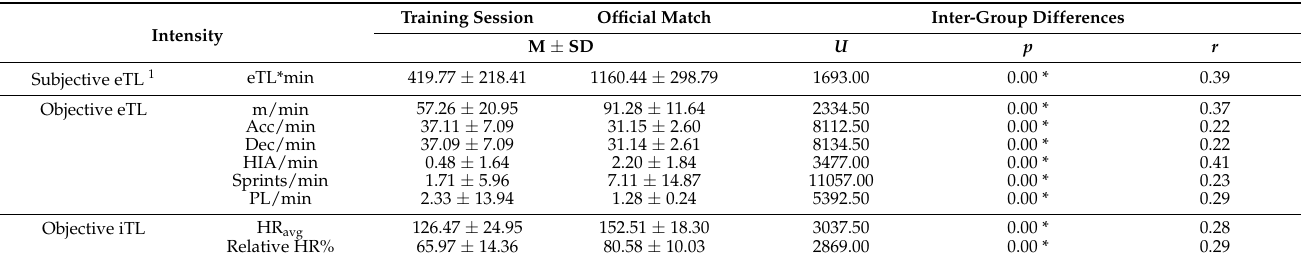
Table 6. Inferential results for the intensities according to the type of